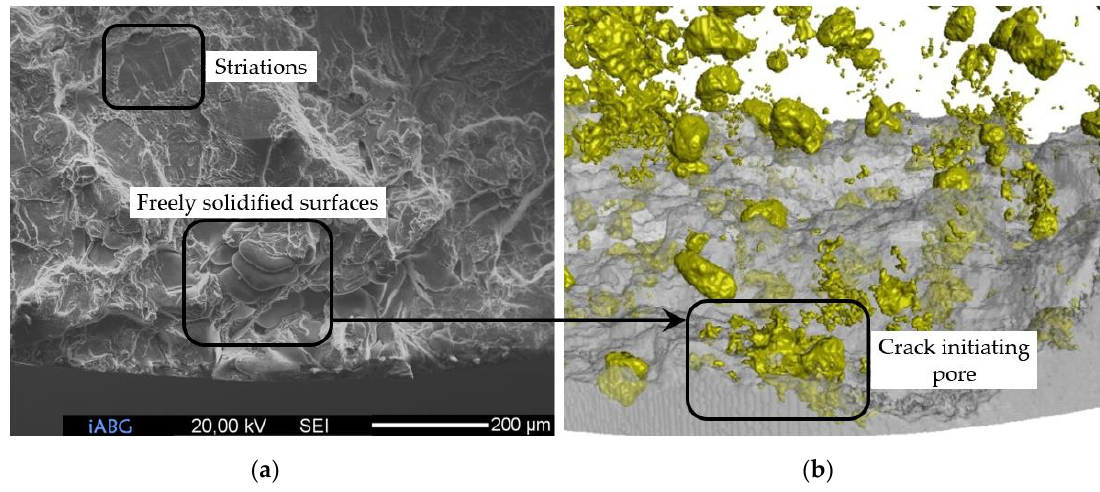
Figure 4. ( a) Crack origin detected by scanning electron microscopy (SEM); ( b ) Crack-initiating pore detected by X-ray micro computer tomography (μCT).